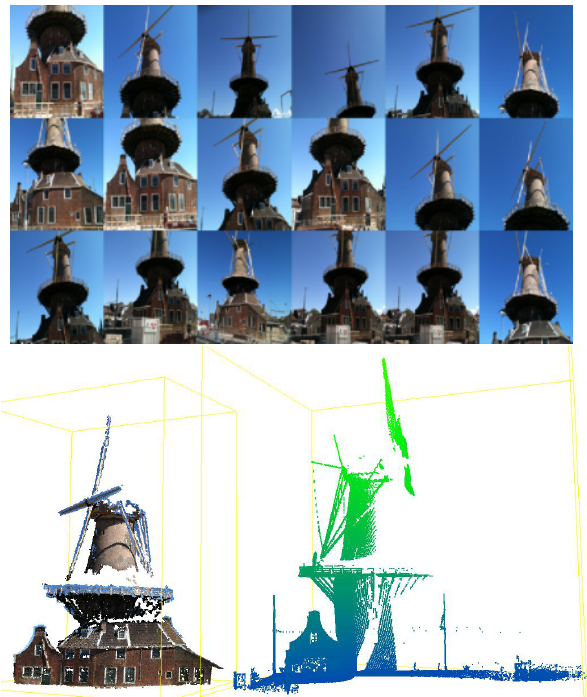
Figure 2: Top; a collage of the sample iPhone images which are used for point cloud generation. Bottom; The point cloud obtained based on multi-view